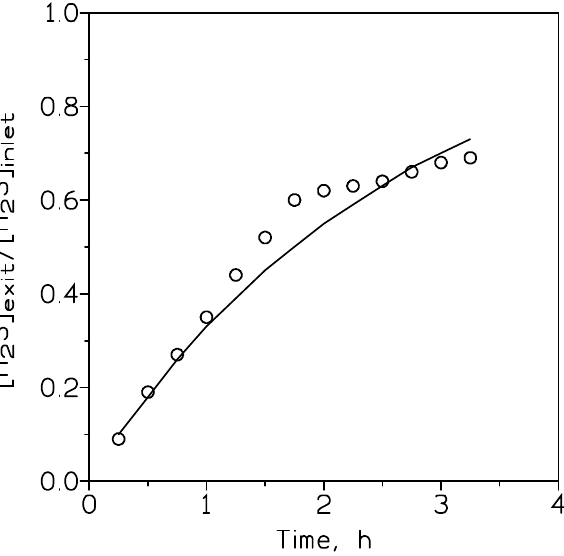
Figure 5. Experimental (circles) and Equation (3) model (line) data of experiments under the following conditions: adsorbent dosage: 4 g. H 2 S dosage: 400 mg. Gas flow: 210 cm 3 /min. Temperature: 20 °C.